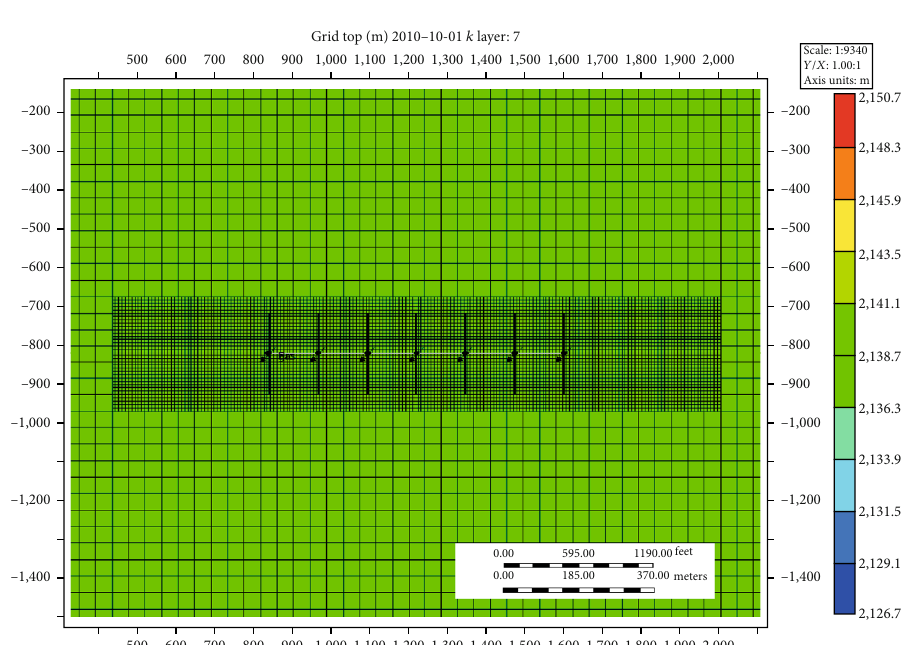
Figure 5: Planar grid distribution of the single horizontal well